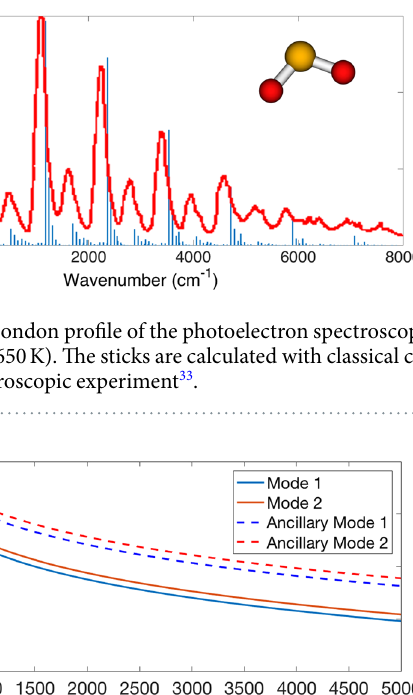
− → SO 32 at 2 ) 2 2 k , s k is a squeezing parameter 10